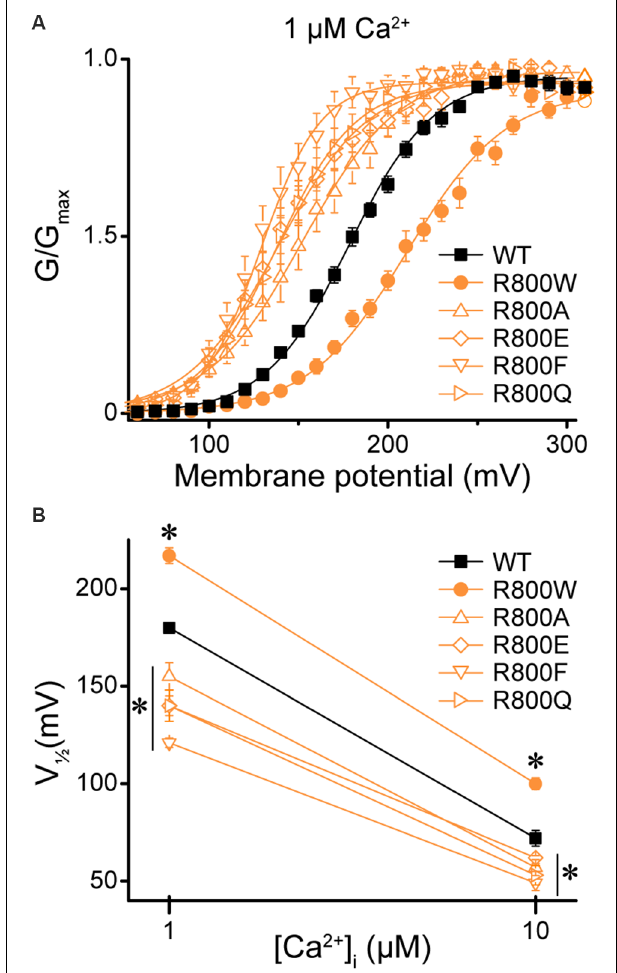
FIGURE 8 | Effects of C495G on redox modulation of BK currents. Experiments were performed on the hBK VYR splice variant background in symmetrical K + solutions at 10- µ M Ca 2 + . Voltage protocols were identical to those in Figure 2 . (A) V 1 / 2 values obtained from BK currents at 1 min